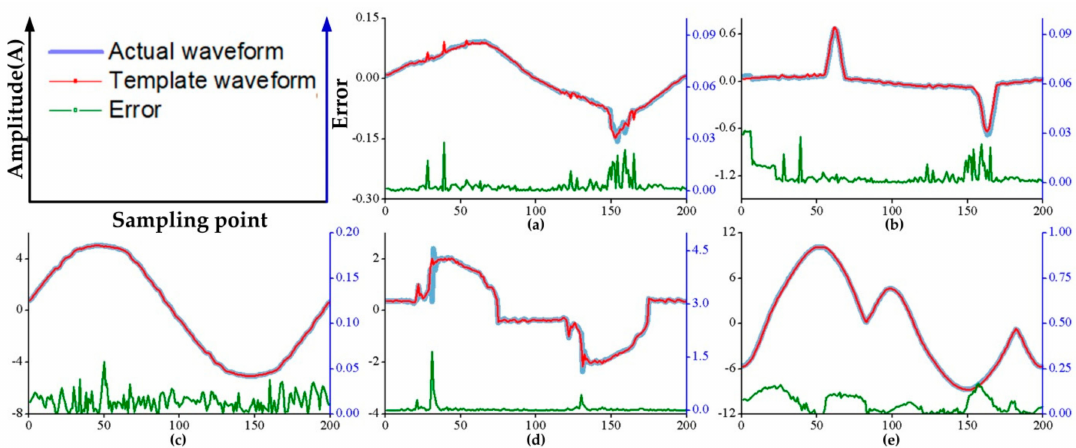
Figure 7. The signal in load-signature database and actual waveform; ( a ) and ( b ) are the computers of di ff erent brand; ( c ) is the kettle; ( d ) is the printer; ( e ) is the microwave oven.